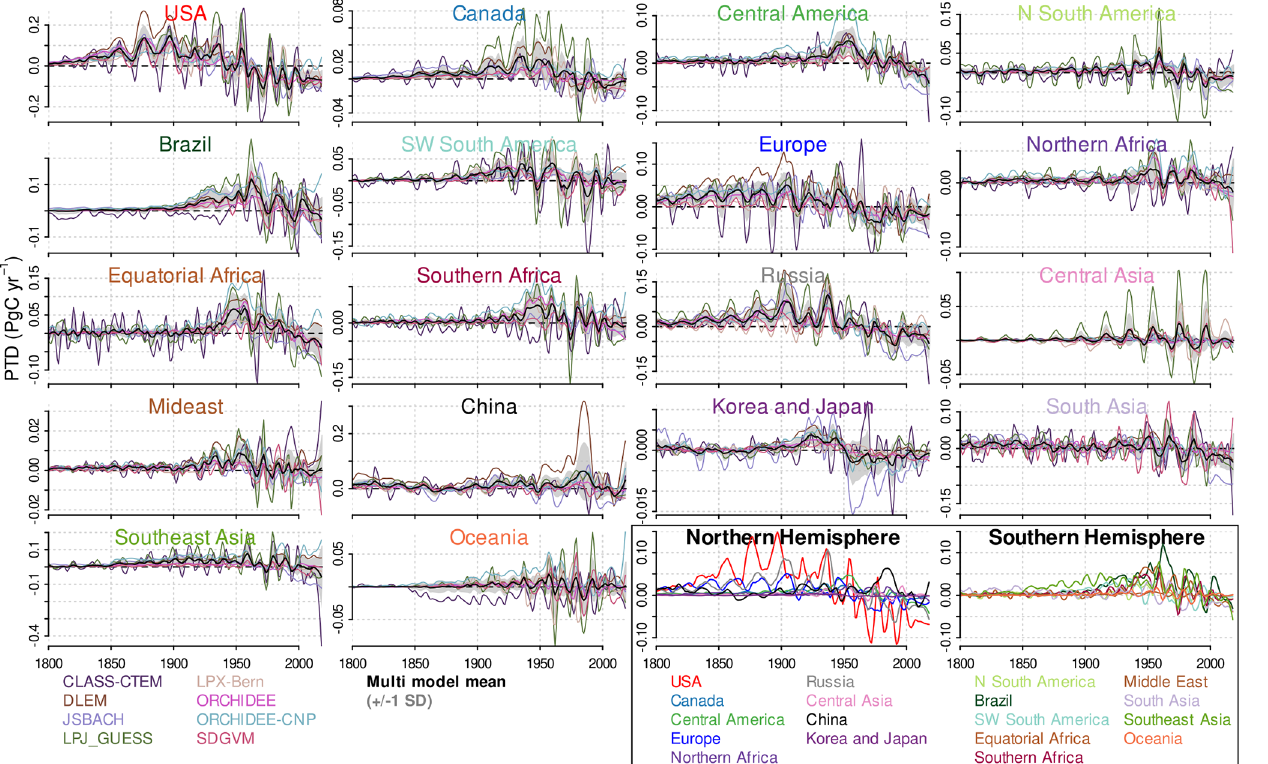
Figure A5. Region-wise smoothed annual “present-day” vs. “transient” environmental conditions difference in the f LULCC (PTD) in the used models from 1800 to 2018, derived according to Eq. (5). For a discussion of individual models refer to Sect. A1. The PTD was not derived for CLM5.0, JULES, LPJ, and OCN (compare Table 2). The last two panels show regional ensemble means on a uniform